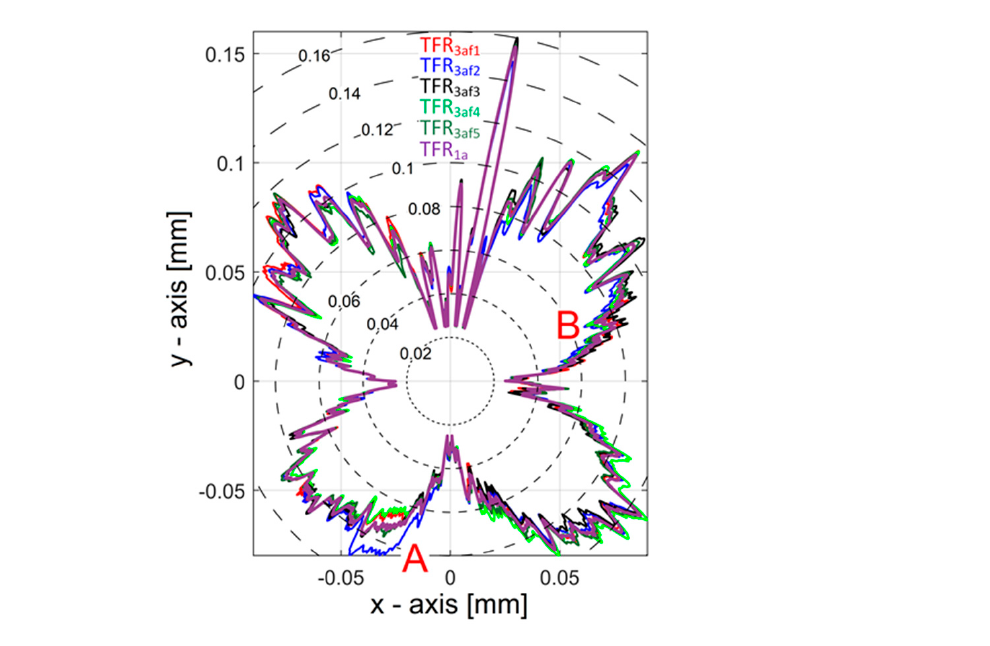
Figure 20. The evolution of TFR 3af trajectory for five successive real trajectories (TFR 3af1 ÷ TFR 3af5 ) and the evolution of TFR 1a .